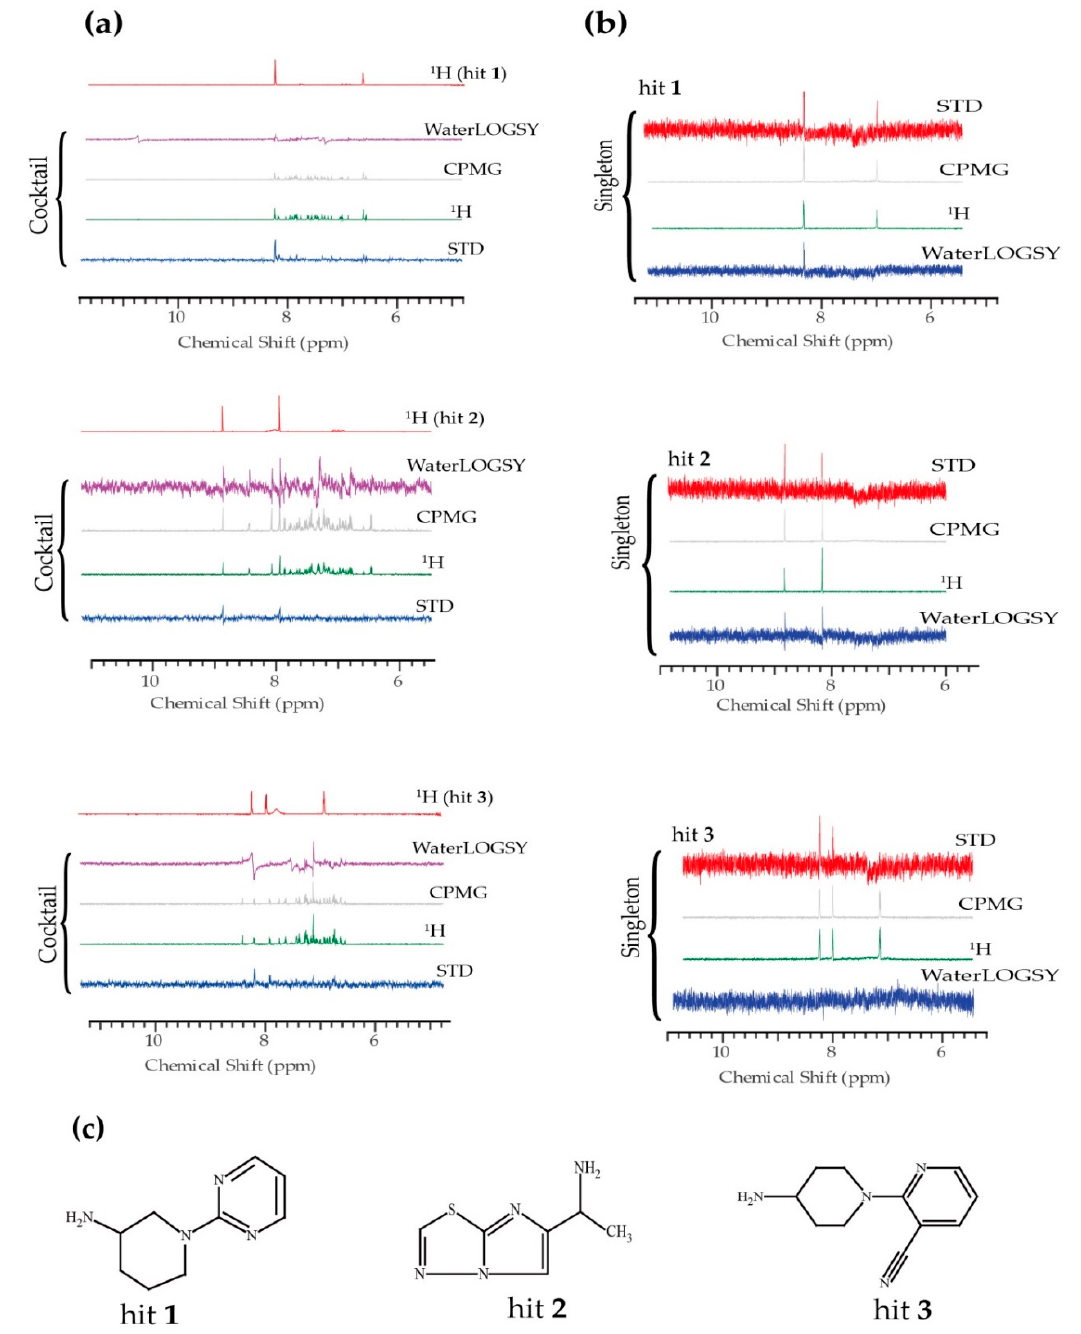
Figure 1. NMR fragment-based screening against the tandem RRM domain of TDP-43. ( a ) The primary screening WaterLOGSY, CPMG, 1 H and STD spectra for three representative cocktails. The 1 H reference spectrum of the respective hit is shown for comparison. ( b ) The secondary screening spectra for individual hit 1, 2, and 3, respectively. ( c ) The chemical structures of hits 1, 2, and 3.